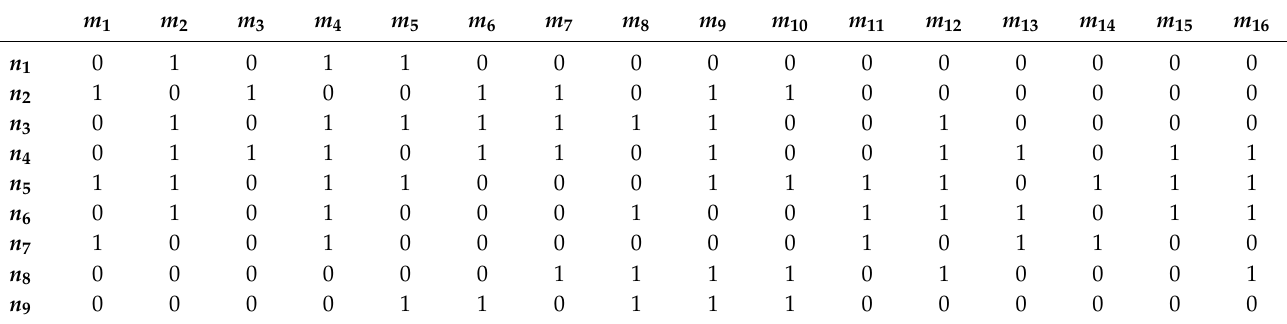
Table 12. Transport travel matrix for Variant #3.